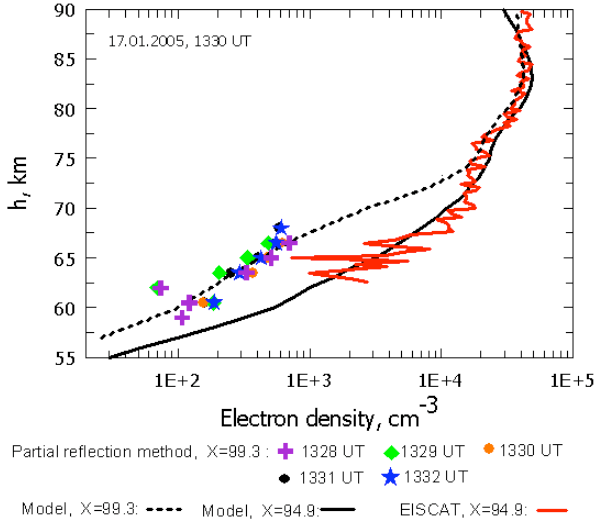
Fig. 9a. Electron density profiles measured (red solid curve and symbols) and calculated for the SPE on 17 January 2005 at 13:00UT for zenith angles 93.4 ◦ and 96.2 ◦ using the O, O 3 and NO profiles 4–6 in Fig. 1 (black curve).